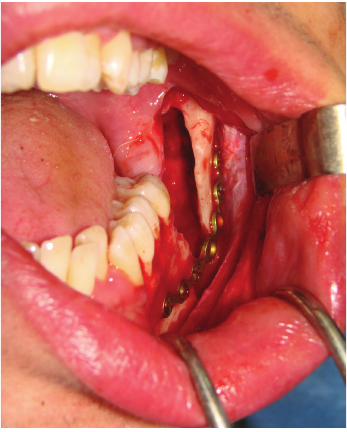
Figure 3: Postoperative intraoral view. Rigid fixation of split segments of the mandible.